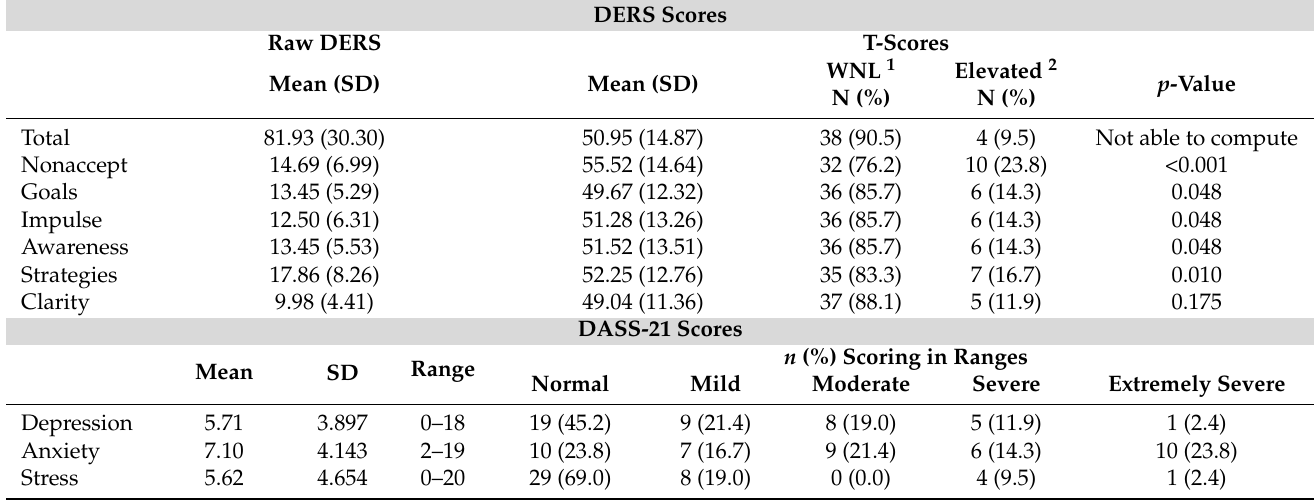
Table 2. Means and proportions of depression, anxiety, stress and emotion regulation scores. DERS Scores